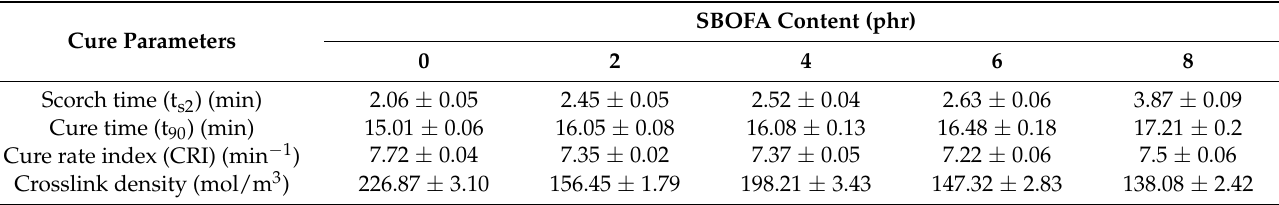
Table 5. Cure parameters of NBR compounds with varying SBOFA loadings.